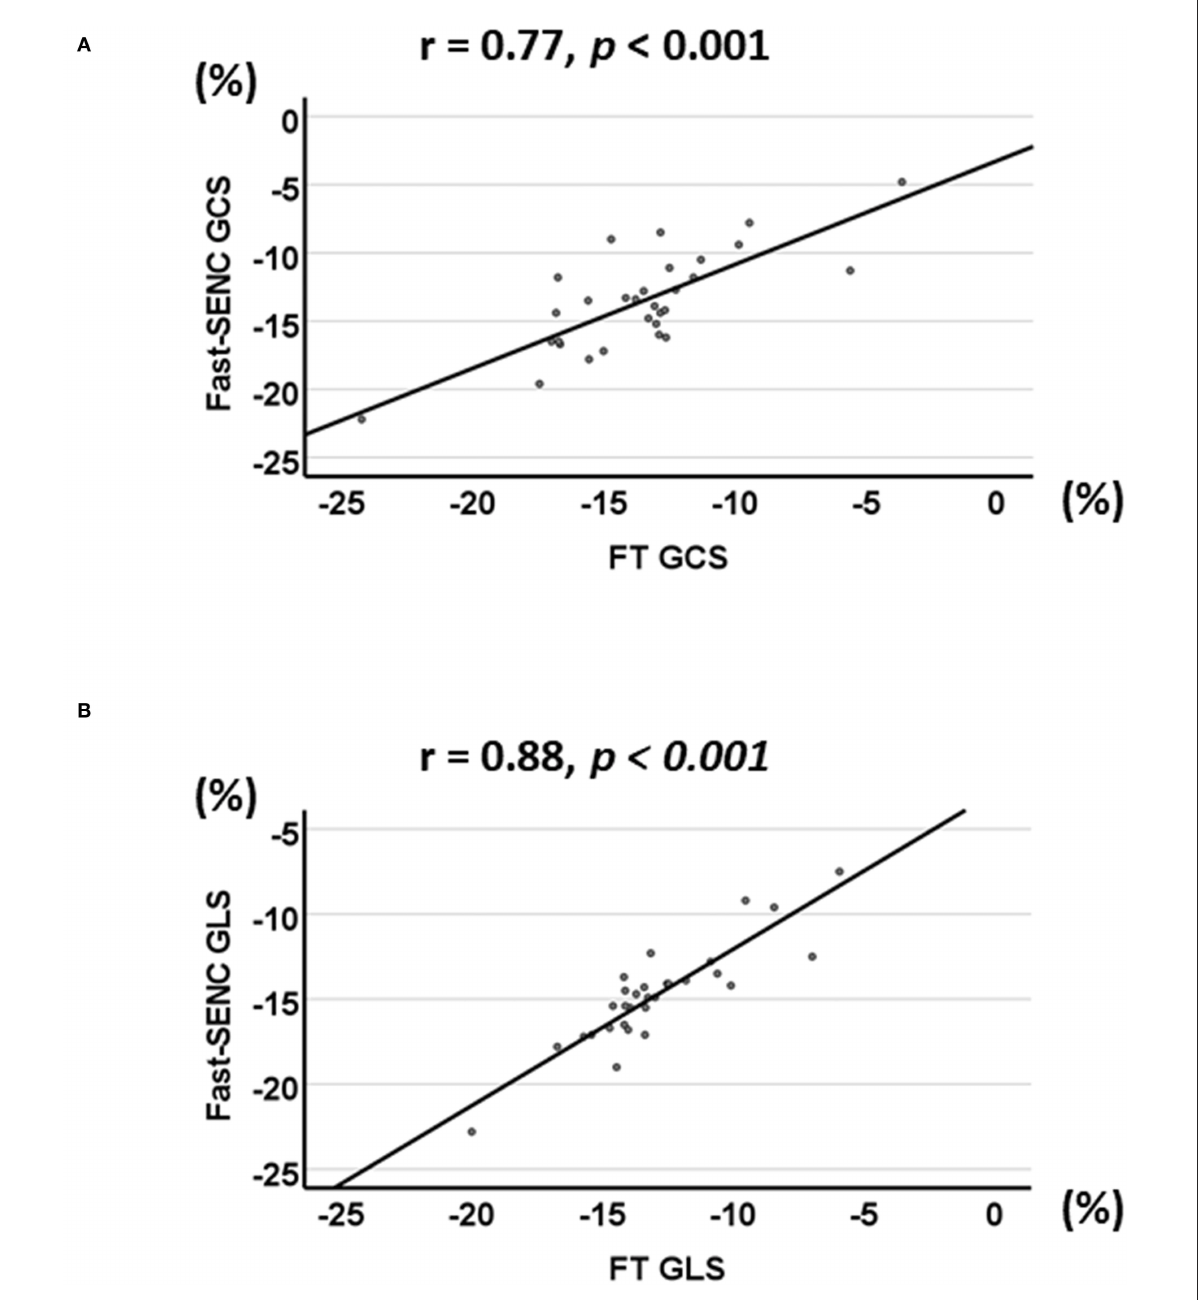
FIGURE4 Linear correlation ( r ) between fast-SENC and FT for GCS (A) and GLS (B)